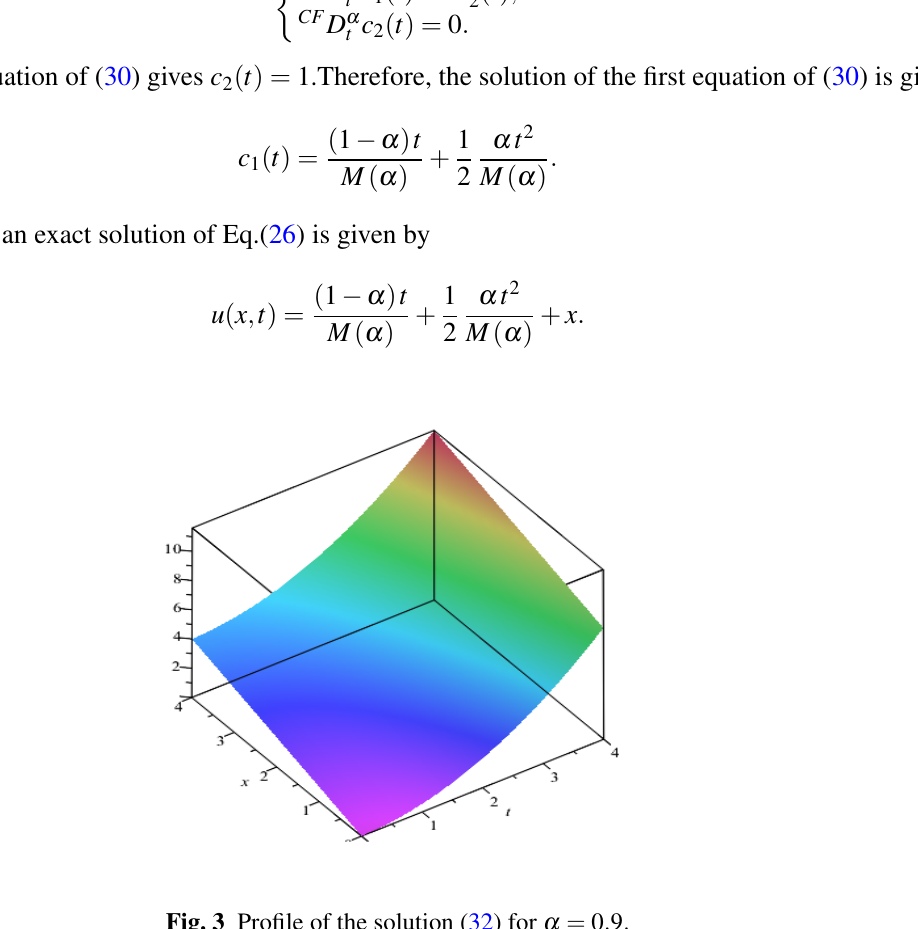
Fig. 3 Profile of the solution (32) for α = 0 . 9